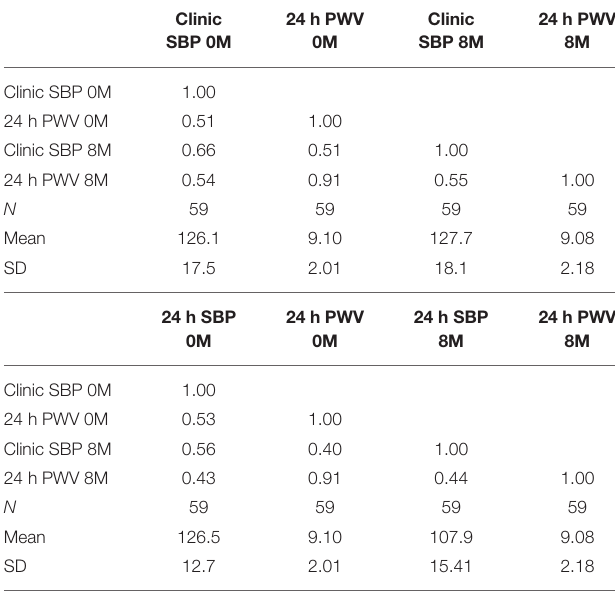
TABLE 2 | Correlation matrix and descriptive statistics for PWV and clinic and 24h peripheral SBP at baseline (0M) and 8-month (8M) assessments ( n =